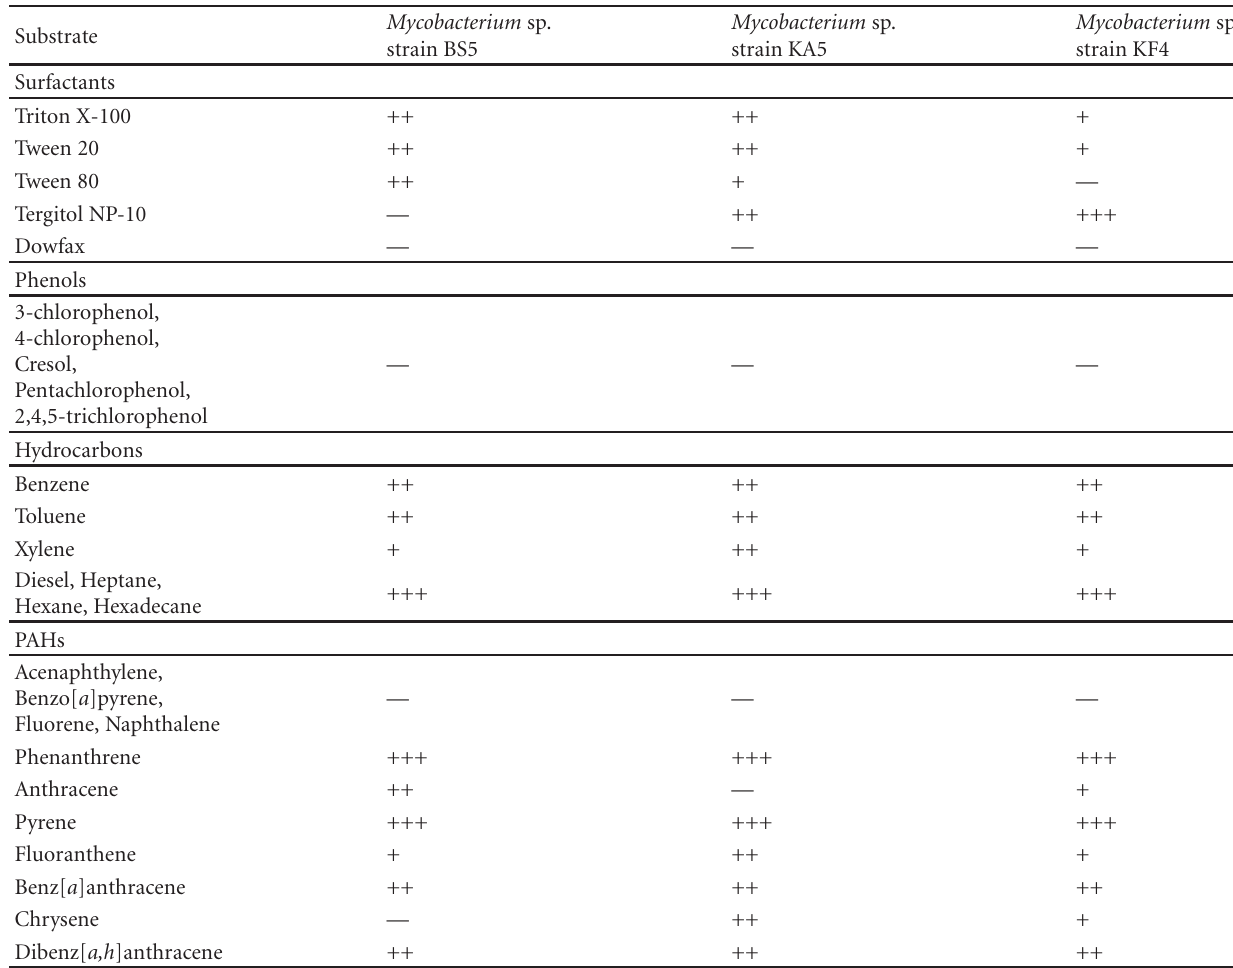
Table 4: Growth of Mycobacterium sp. isolates on various surfactants, phenols, hydrocarbons, and PAHs. Growth was scored visually on the basis of turbidity and ranked accordingly (see Table 3 for turbidity rankings).